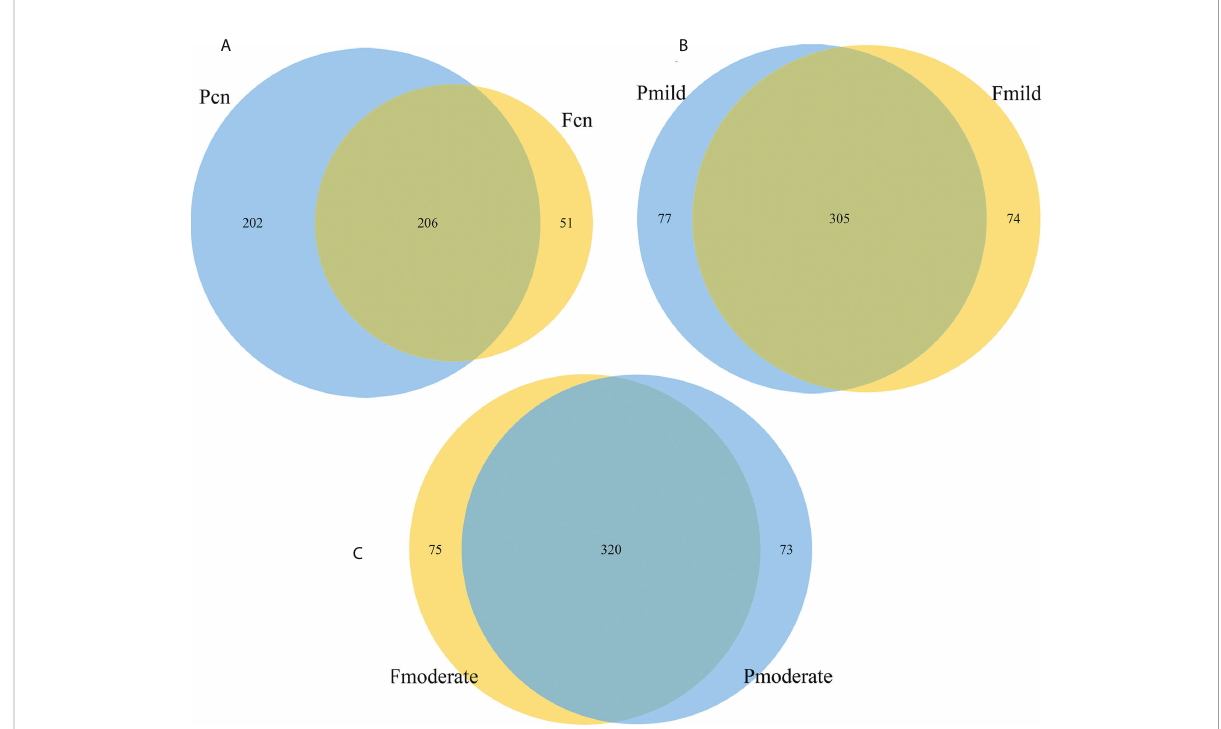
FIGURE 7 The similarity and overlap with oral and fecal microbiotas. The Venn diagrams illustrate all overlapping genera identi fi ed in the oral and gut microbiota in the normal control (A) , the mild AD (B) , and the moderate AD (C) groups. Subgingival and gut microbiomes are colored in blue and yellow nodes, respectively. Pcn, subgingival plaque of normal cognition controls; Fcn, feces of normal cognition controls; Pmild, subgingival plaque of mild AD; Fmild, feces of mild AD; Pmoderate, subgingival plaque of moderate AD; Fmoderate, feces of moderate